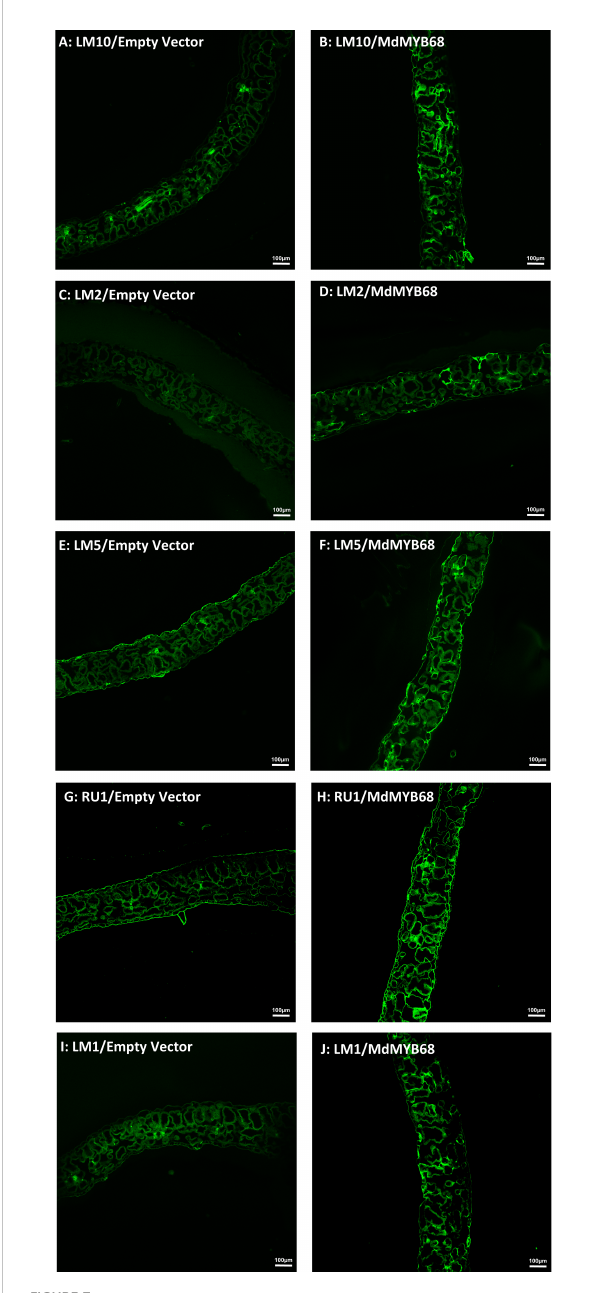
FIGURE 7 Immunodetection performed from N. benthamiana leaf samples collected 7 days after agroin fi ltration with the Empty vector (left side) and MdMYB68 (right side) construct using the following antibodies: LM10 speci fi c for unsubstituted b -1,4-Xylan (A, B) , LM2 speci fi c for carbohydrates containing b -linked glucuronic (C, D) , LM5 speci fi c for b -1,4-D-galactan (E, F) , RU1 speci fi c for unbranched regions of rhamnogalacturonan-I (G, H) , LM1 speci fi c for extensins/HRGP (I, J)